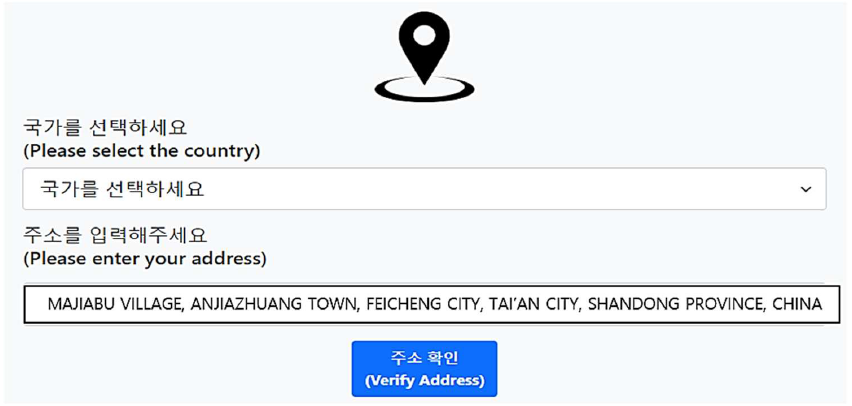
Figure 7. Web-based verification system user interface. Figure 7. Web‑based verification system user interface.